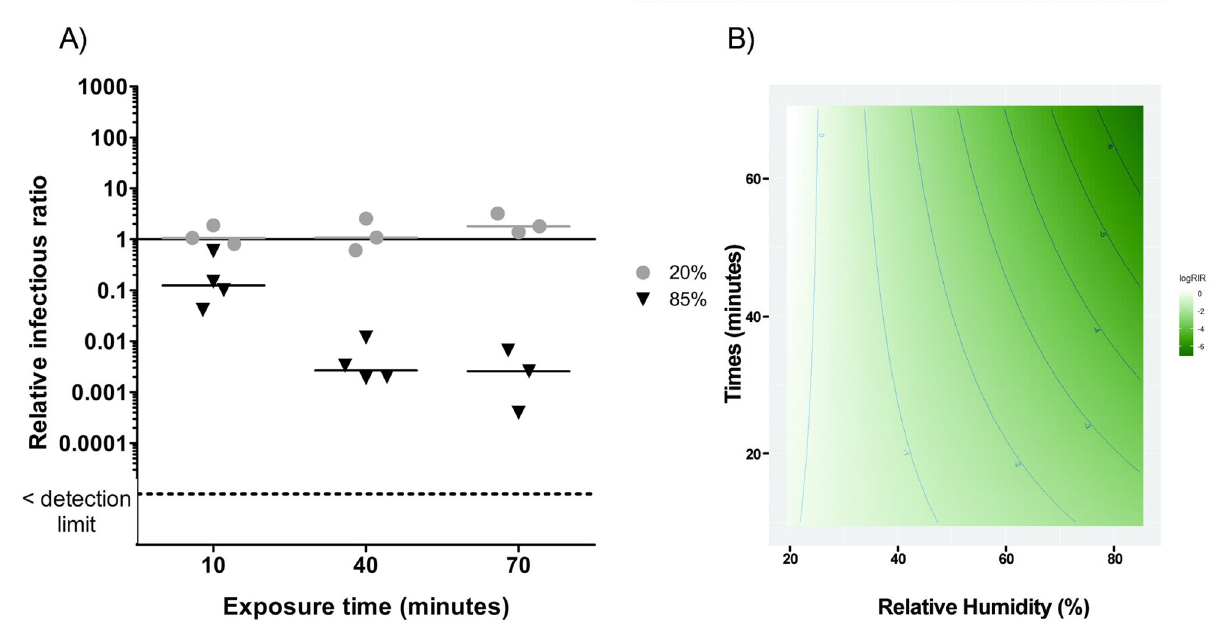
Fig 7. A) Ozone effect on MNV-1 infectivity at two levels of relative humidity and three exposure times. The solid line represents the reference value without ozone. The dotted line represents the detection limit. 20% RH values are represented by circles ( ● ) and 85% RH by triangles ( ▼ ). B) RSM between exposure time and humidity percentages for MNV-1. The darker the green colour, the greater the inactivation related to relative humidity and time